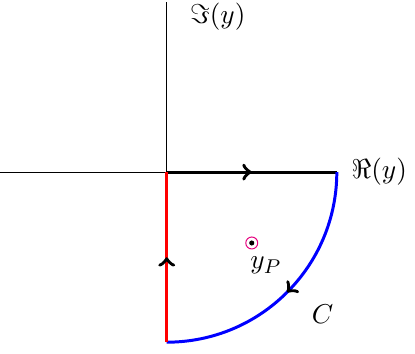
Figure 4. Contour prescription for